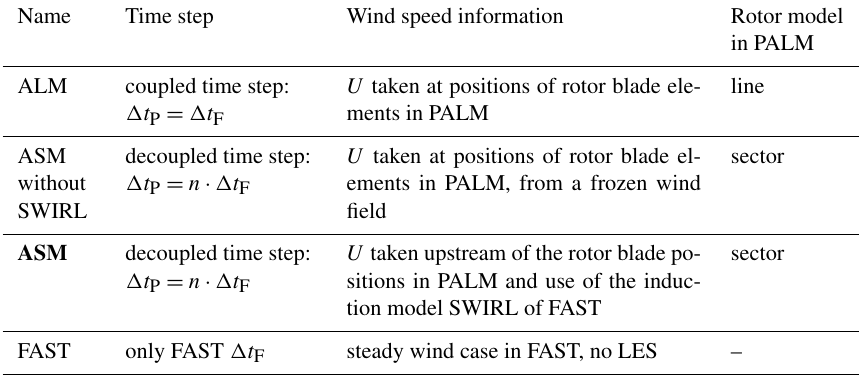
Table 1. Overview of the turbine models that were used in the comparisons. The new enhanced coupling method is ASM, the respective time steps in PALM and FAST are denoted as (cid:49)t P and (cid:49)t F respectively, and the inflow wind speed is denoted as U . The coupled model that is the focus of this paper is highlighted in bold.